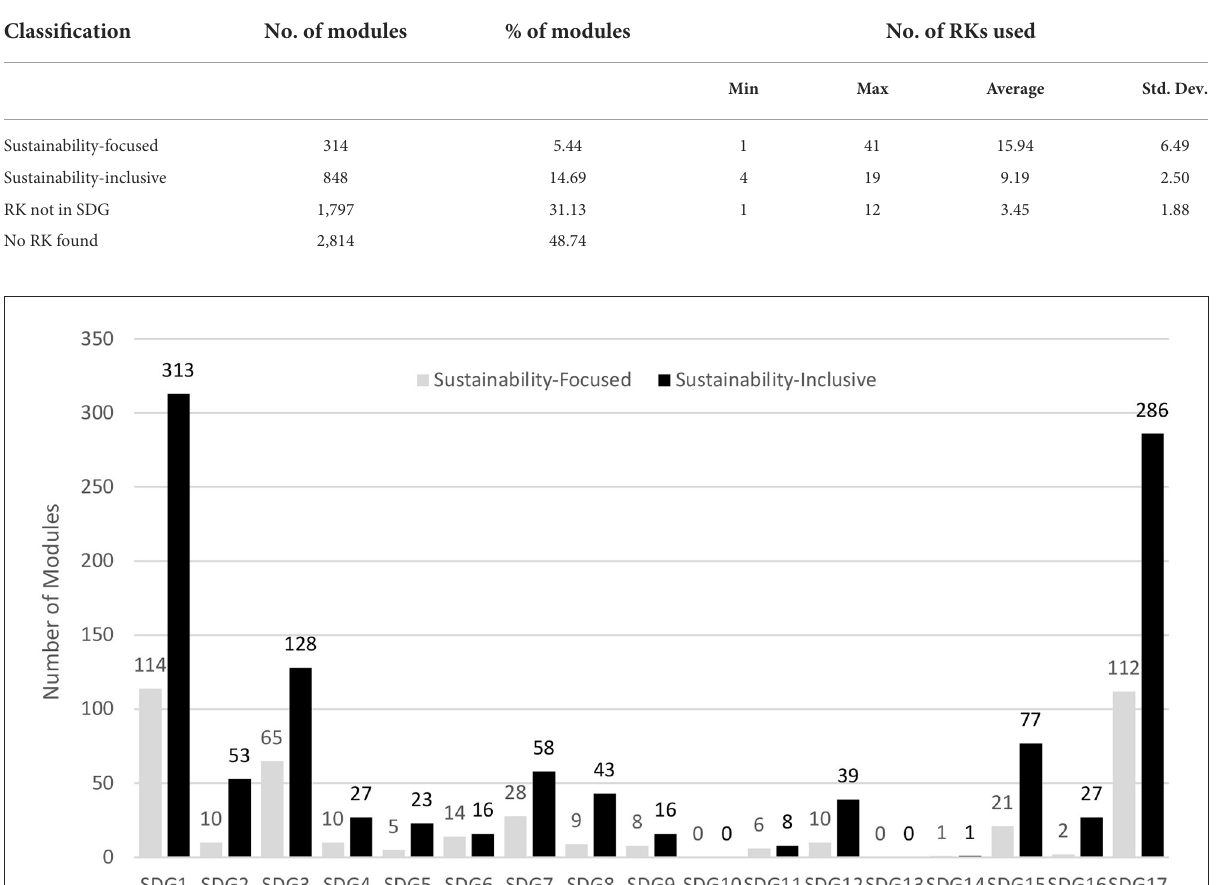
TABLE 5 Classification of modules with RK descriptive statistics.